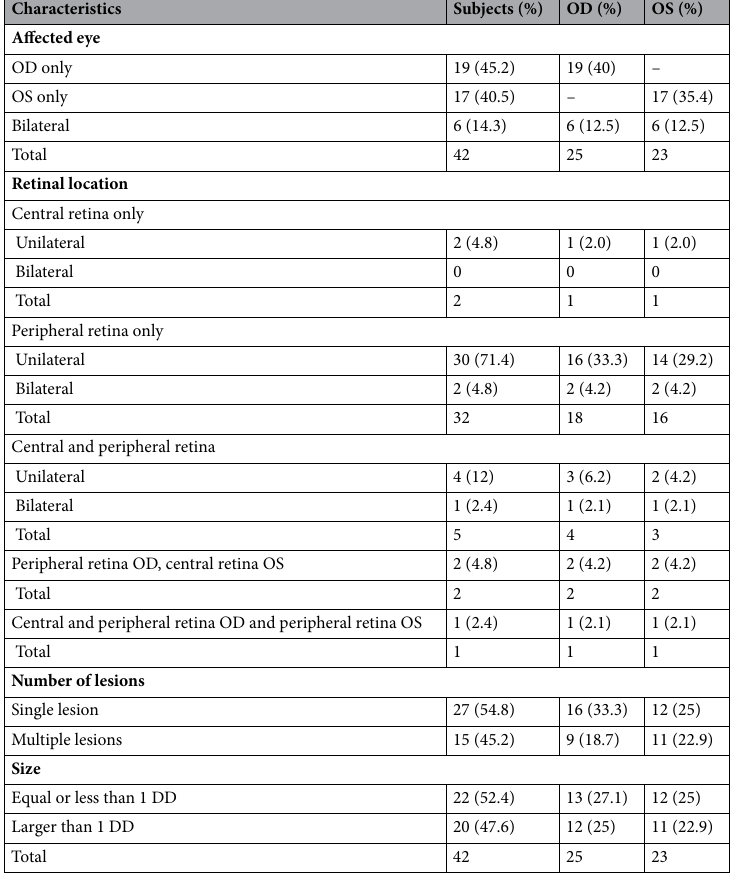
Table 2. Characteristics of subjects and eyes with ocular toxoplasmosis (n = 42 subjects, 48 eyes). OD: right eye; OS: left eye; DD: disc